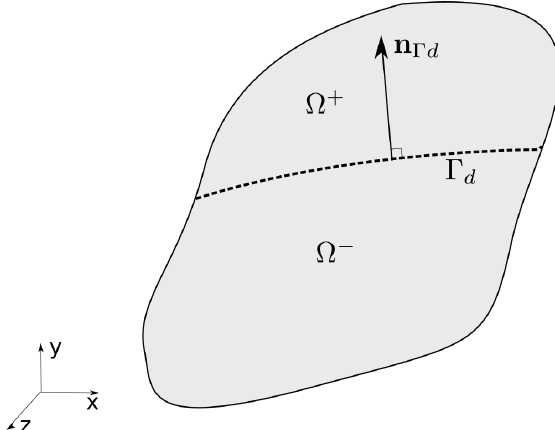
represents the normal of the d